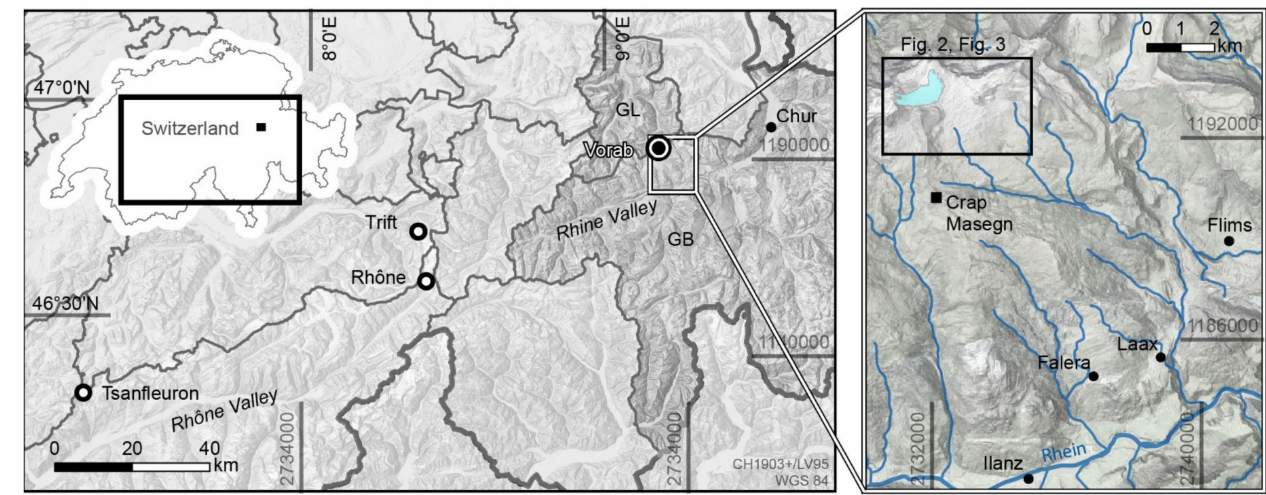
Figure 1. Overview maps. Left: Location of the Vorab glacier (black point) west of Chur at the border between the canton of Glarus (GL) and Grisons (GB). Extent of the map within Switzerland is indicated by the black rectangle on the inset map. Other locations, in the Swiss Alps, where glacial erosion rates were determined using cosmogenic nuclides are indicated as white points. Right: close-up of the study site area, with the Vorab glacier extent (2019) in light blue and the location of the weather station at Crap Masegn. The black rectangle shows the extent of Figures 2 and 3. Background maps and outlines of the cantons are reproduced with the authorization of the Swiss Federal Office of Topography